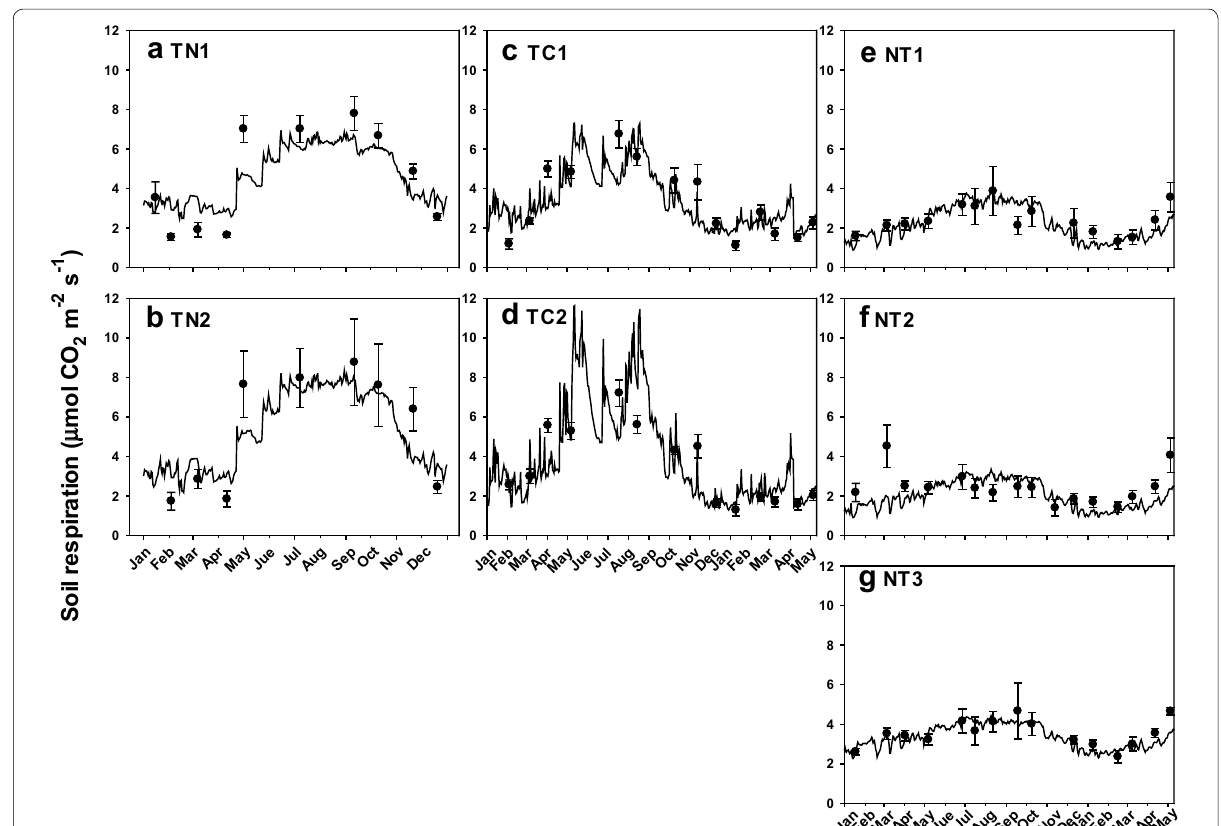
Fig. 3 Soil respiration rate (μmol CO 2 m − 2 s − 1 ) measured in the field (black circles) and modeled by the regression equation (solid line) at TN ( a , b ), TC ( c , d ), and NT ( e – g ) plantations in Taiwan